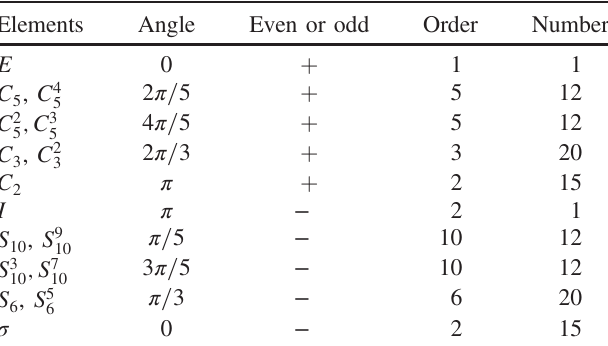
TABLE II. Conjugacy classes of H 3 . The first column is the . The second Schönflies notation for the elements in the class K i column gives the angle of rotation ϕ of the element realized in O i (3). The third column is whether it is generated by an even or odd 1 . All odd elements that are number of reflections π i ¼ (cid:5) rotations can be considered as rotoreflections, i.e., a rotation followed by a reflection in the plane perpendicular to the rotation axis. The fourth and fifth columns are the order of the elements in the class K and the number of elements k in the class, i i